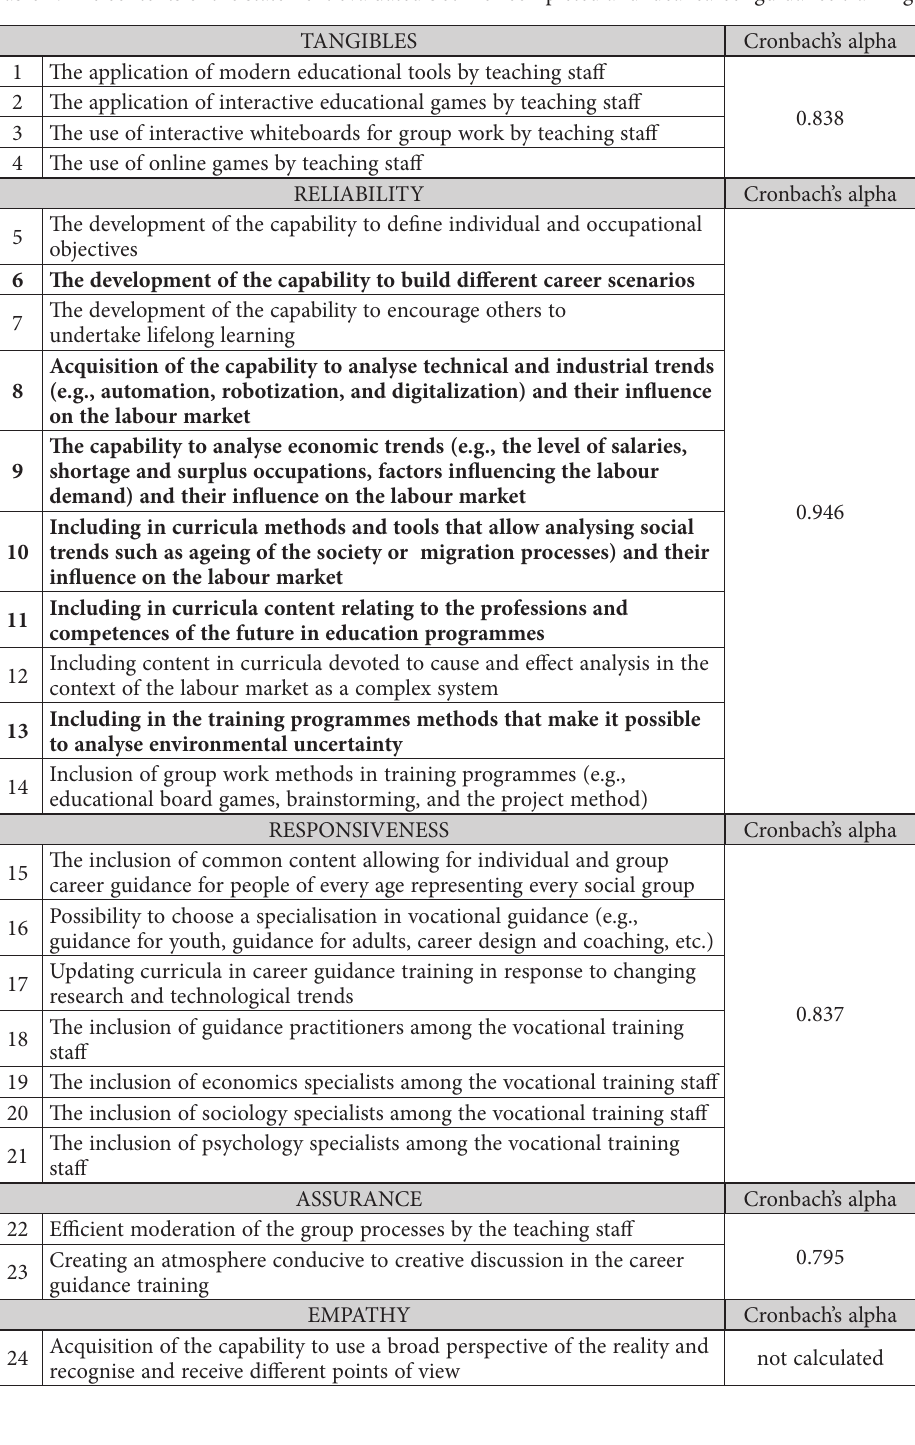
Table 1. The contents of the statement evaluated both for completed and ideal career guidance training